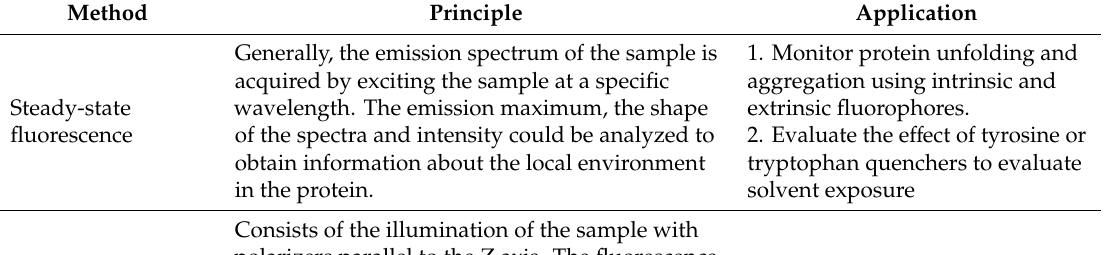
Table 2. Description of the most widely used techniques in fluorescence spectroscopy to characterize protein self-assembly in